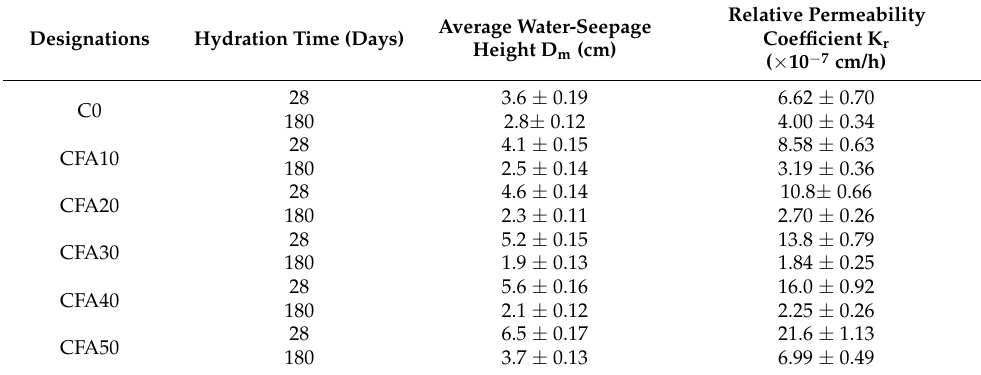
Table 3. The permeability results of the face slab concretes with fly ash at 28 and 180